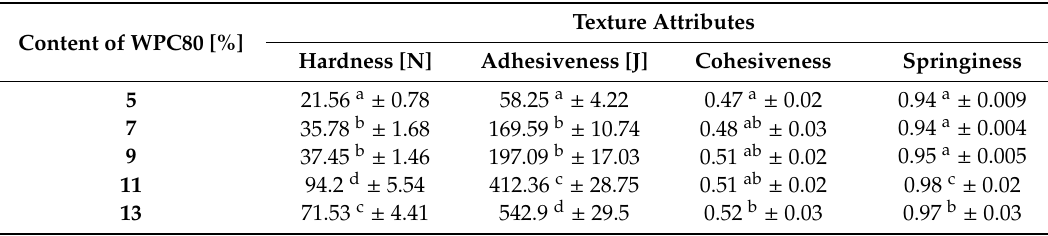
Table2. E ff ectofdi ff